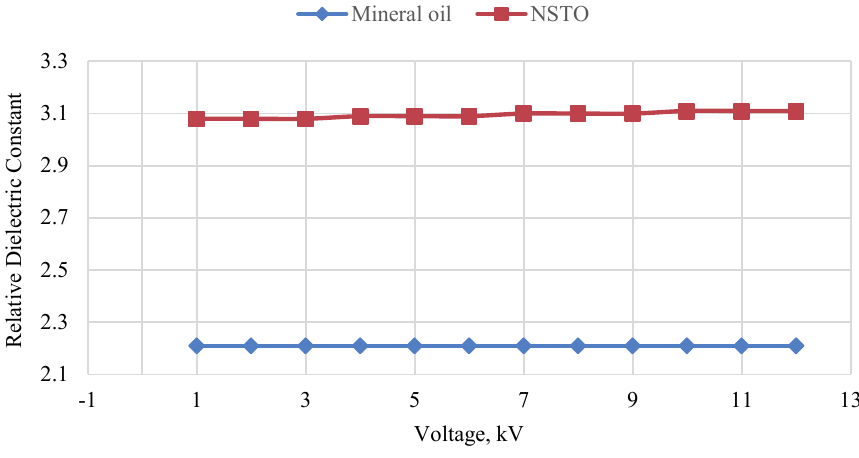
Fig. 3. Relative dielectric constant changes in relation to